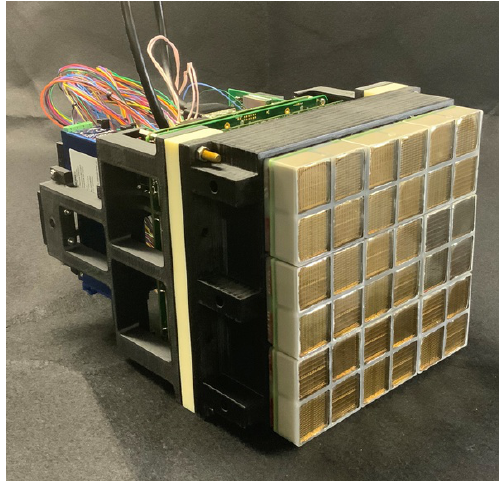
Figure 7. K-EUSO electronics. Photo of an assembled PDM.